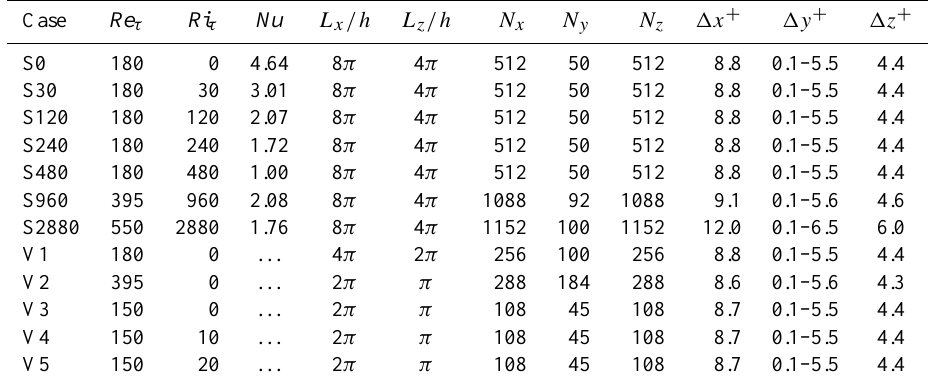
Table 1. Summary of the simulation configurations used in this study. Re τ is friction Reynolds number; Ri τ is friction Richardson number; Nu is Nusselt number; L x and L z are the domain lengths in the streamwise ( x ) and spanwise ( z ) directions, respectively; h is the open- channel height in the vertical ( y ) direction ( h is set to be 1.0 for the current study); N x , N y , N z are the cell numbers in x , y , z directions, respectively; and (cid:49)x + ,(cid:49)y + ,(cid:49)z + are the normalized grid resolutions (e.g., (cid:49)x + = (cid:49)xu τ /ν ). The smaller and larger (cid:49)y + represent the vertical grid resolution at the bottom and the top walls, respectively.